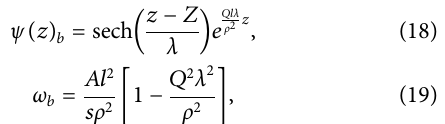
Frontiers in Physics |